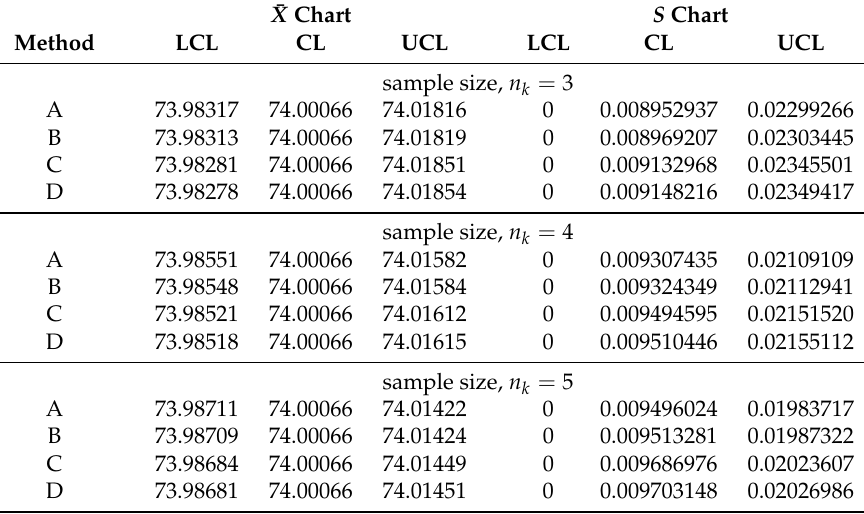
Table 6. Control limits for the ¯ X and S charts for Example